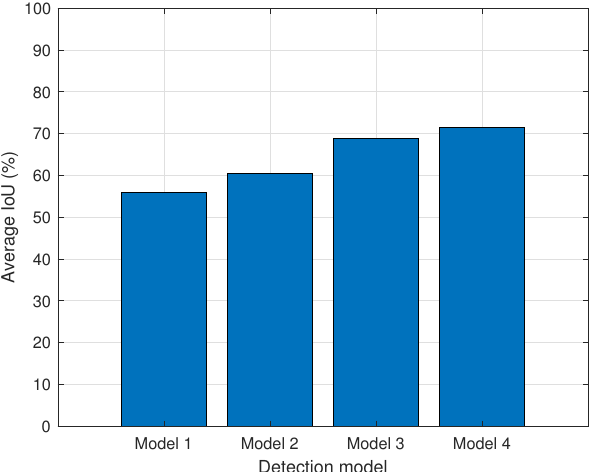
Figure 5. Average IoU for each recognition